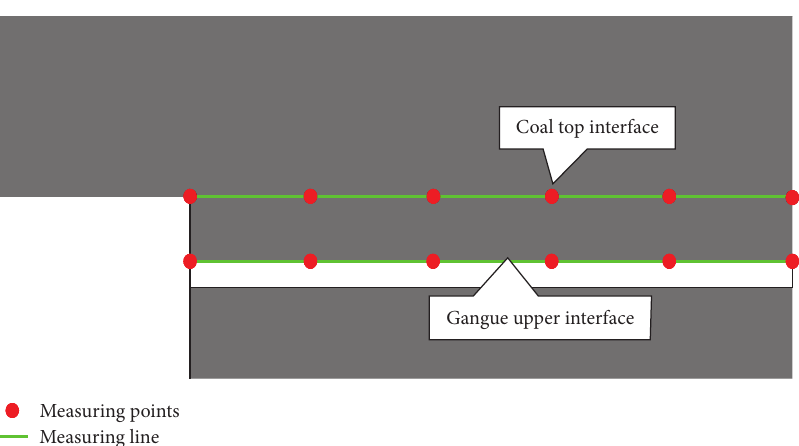
Figure 3: Layout of measuring lines and measuring